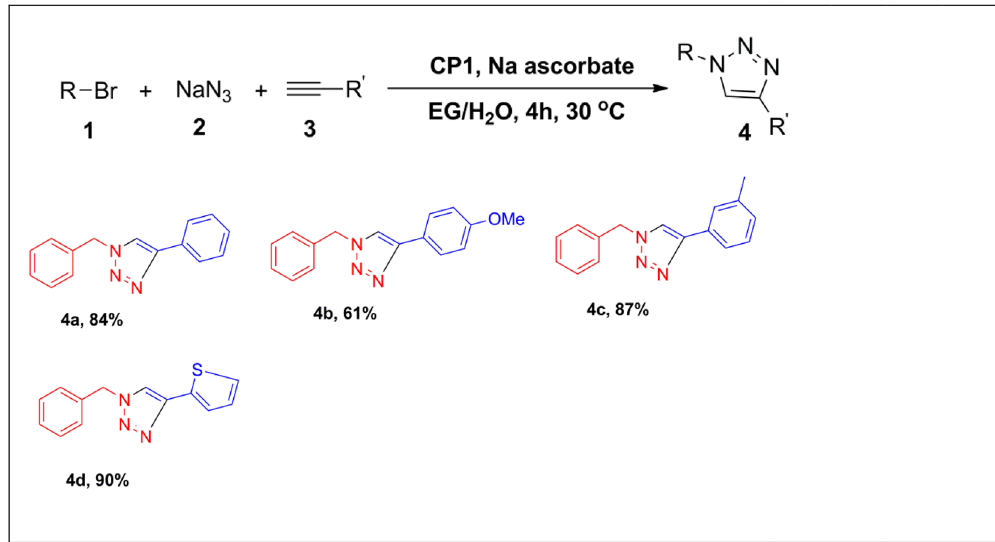
Table 3. 1D copper-based coordination polymer catalyzed multicomponent synthesis of 1,4-disubsttuted 1,2,3-triazoles a . a Reaction conditions: Benzyl bromide (1.0 mmol), NaN 3 (1.1 mmol), alkyne (1.2 mmol), CP1